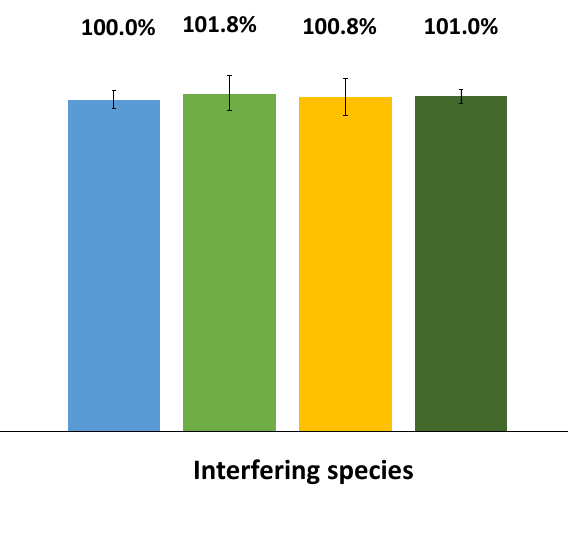
Figure 7. Selectivity study for the CA 15-3 biosensor. The interfering species used were BSA (1 mg/mL), CEA protein (3 ng/mL), and CA 125 (30 U/mL). The samples with 30 U/mL of CA 15-3 were all diluted as for the serum tests (n = 3).